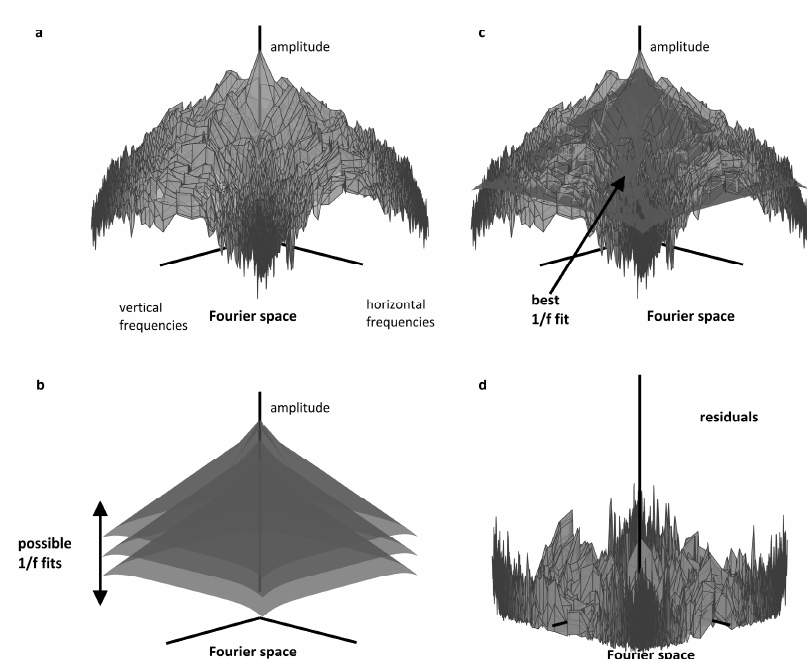
Figure 6. Schematics of the method used in [25]. ( a ) Amplitude spectrum of a natural image in log–log coordinates. Each vertex on the surface has three coordinates: two corresponding to the logarithm of the spatial frequency in the two-dimensional Fourier domain (frequencies with a DC component have been discarded for display purposes). The third (vertical) coordinate corresponds to the amplitude of the spectrum of the image at these frequencies. ( b ) Family of circular regular cones of slope 1 / f with a (continuously) varying gain. ( c ) Amplitude spectrum pictured in ( a ) with its best fit amongst the (continuous) family of two-dimensional cones pictured in ( b ). ( d ) Residuals after the cone of best fit is removed. After [25].